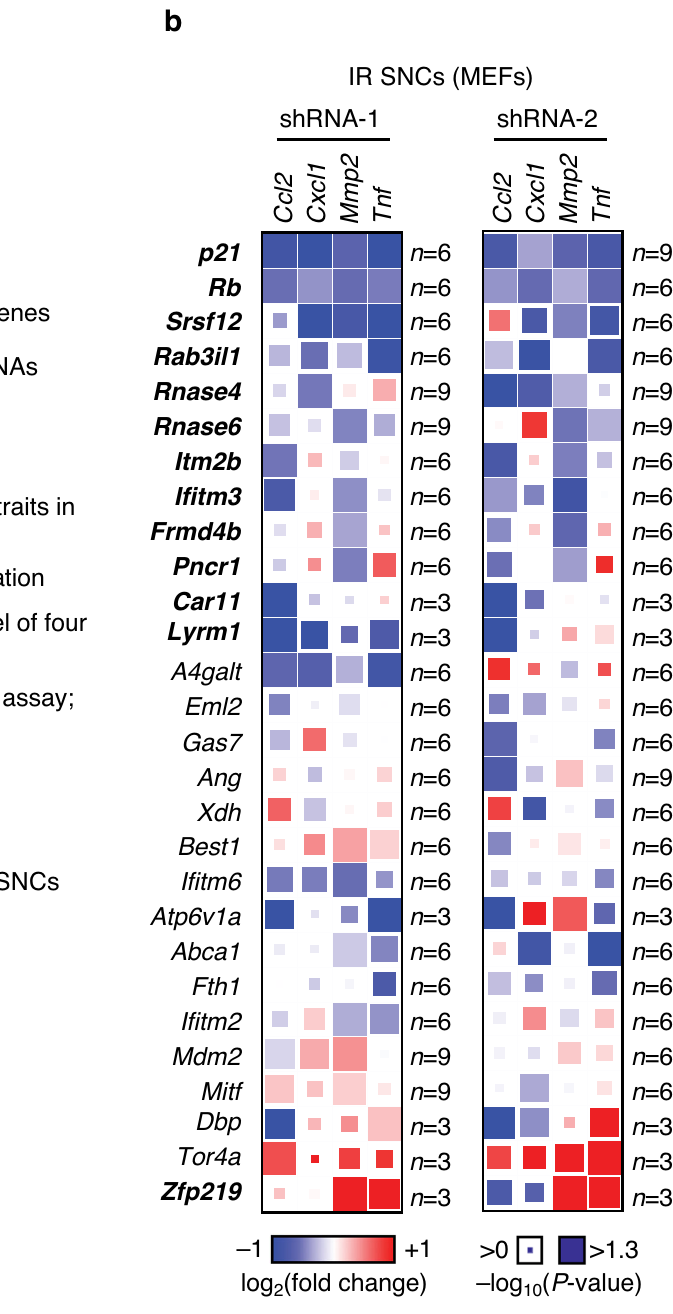
Fig. 1 A subset of SASE genes controls the expression of select SASP factors. a Strategy for the systematic characterization of a subset of 28 SASE genes (here de fi ned as genes 50 kb up- or down-stream of a SASE and transcriptionally induced in SNCs). Involvement of individual SASE genes in three core properties of SNCs was fi rst assessed in IR-SNCs. Signi fi cant results consistently obtained with two shRNAs were validated in REP- and OI-SNCs. b Heatmap depicting log 2 fold changes of the expression of the indicated SASP factors in IR-SNCs three days after SASE gene knockdown as assessed by RT-qPCR. Expression levels of these factors in the same IR-SNC cultures infected shScr- virus were used to assess fold changes. Heatmap shows log 2 fold changes as box color and statistical signi fi cance using paired, two-tailed t -tests as box size. Data represent means. n depict independent MEF lines that were pooled from 1 to 3 independent experiments in b . Source data are provided as a Source Data fi